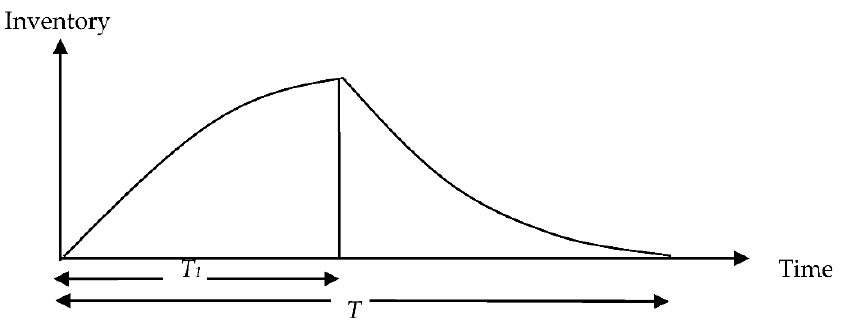
Figure 1. Behavior of producer’s inventory level versus time.